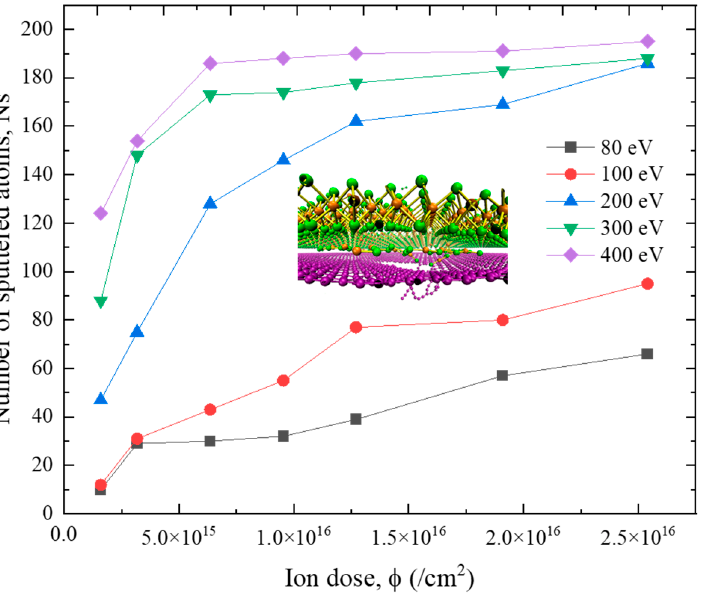
Figure 8. Number of the sputtered atoms of the M/G heterostructure under ion irradiation with different ion energies and ion doses. The inserted figure shows the cross-section enlarged view of the irradiated heterostructure.